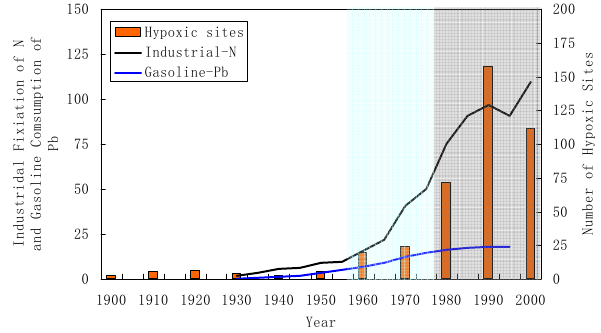
Figure 3. Fig. 3. Temporal relationship between the number of coastal hy- poxic sites (Hypoxic sites: events/decade), accumulative industrial fixed nitrogen (Industrial-N: × 10 6 tons), and alkyl Pb consump- tion (Gasoline-Pb: × 10 5 tons) in US and major European coun- tries (i.e. France, Germany, Italy and UK, altogether accounting for 70% of EU gasoline consumption). Gasoline-Pb is another indicator of anthropogenic perturbations on marine environment but mostly through the atmospheric pathway. The leveling-off of alkyl Pb con- sumption took place in the 1970s–1980s because of bans against lead use in gasoline, and since then Pb level in ocean surface wa- ters has decreased. Industrial fixed nitrogen, mainly used for fer- tilizer application, shows a fast increase in the 1960s–1970s and a slow-down after the 1980s; the number of coastal hypoxic sites per decade dramatically increased after the 1960s and reached a peak in the 1990s. It is believed that 1960–1980 was a period of explosive increase of coastal eutrophication (i.e. light green shad- owed area). However, in developing and economically emerging countries, coastal eutrophication and hypoxia has become more se- rious in the period of 1980–2000 (i.e. grey shadowed area) (modi- fied from Boyle, 2001; Boesch, 2002; Diaz and Rosenberg,